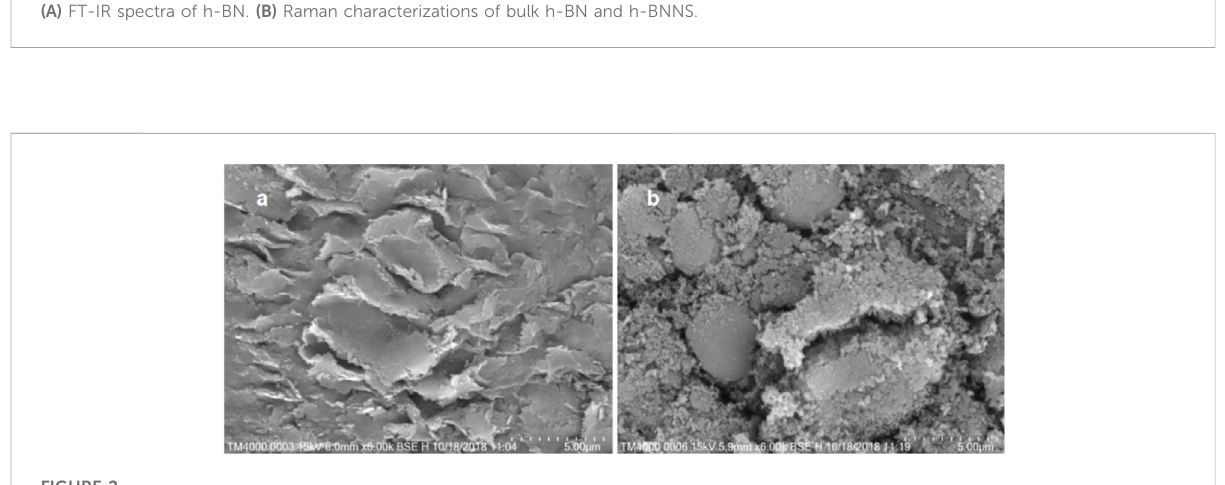
FIGURE 2 Characterization of exfoliated h-BNNS. (A) SEM of h-BN. (B) SEM of